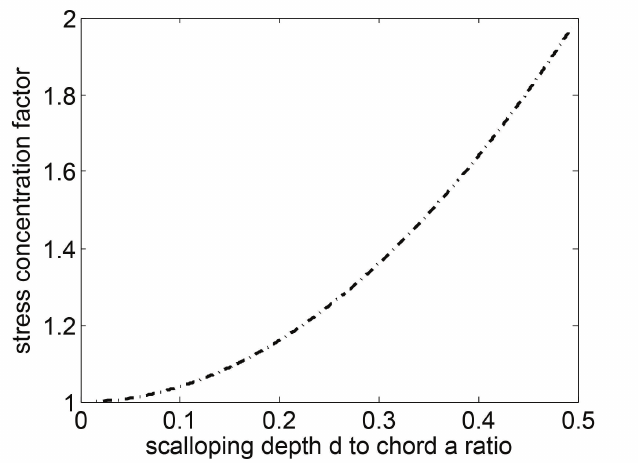
Figure 18. Stress Concentration Factor vs. δ